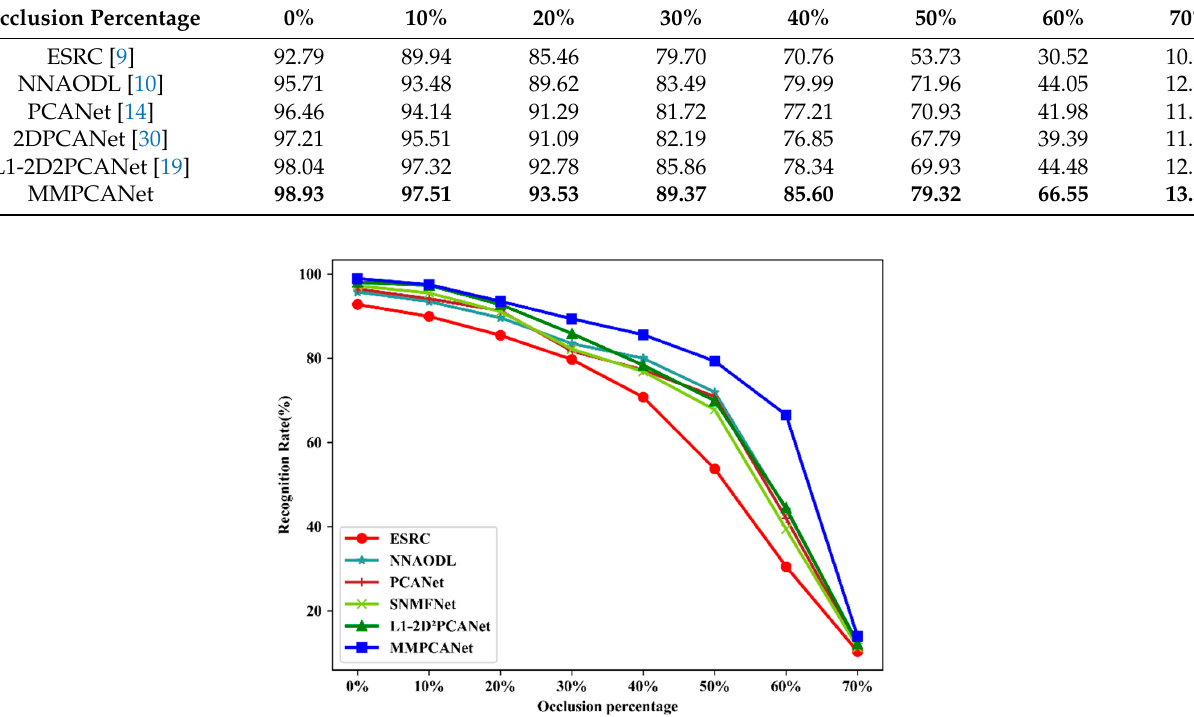
Figure 7. Some examples of face images under different occlusions in AR database. Table 6. Average Recognition Rate (%) on AR database.